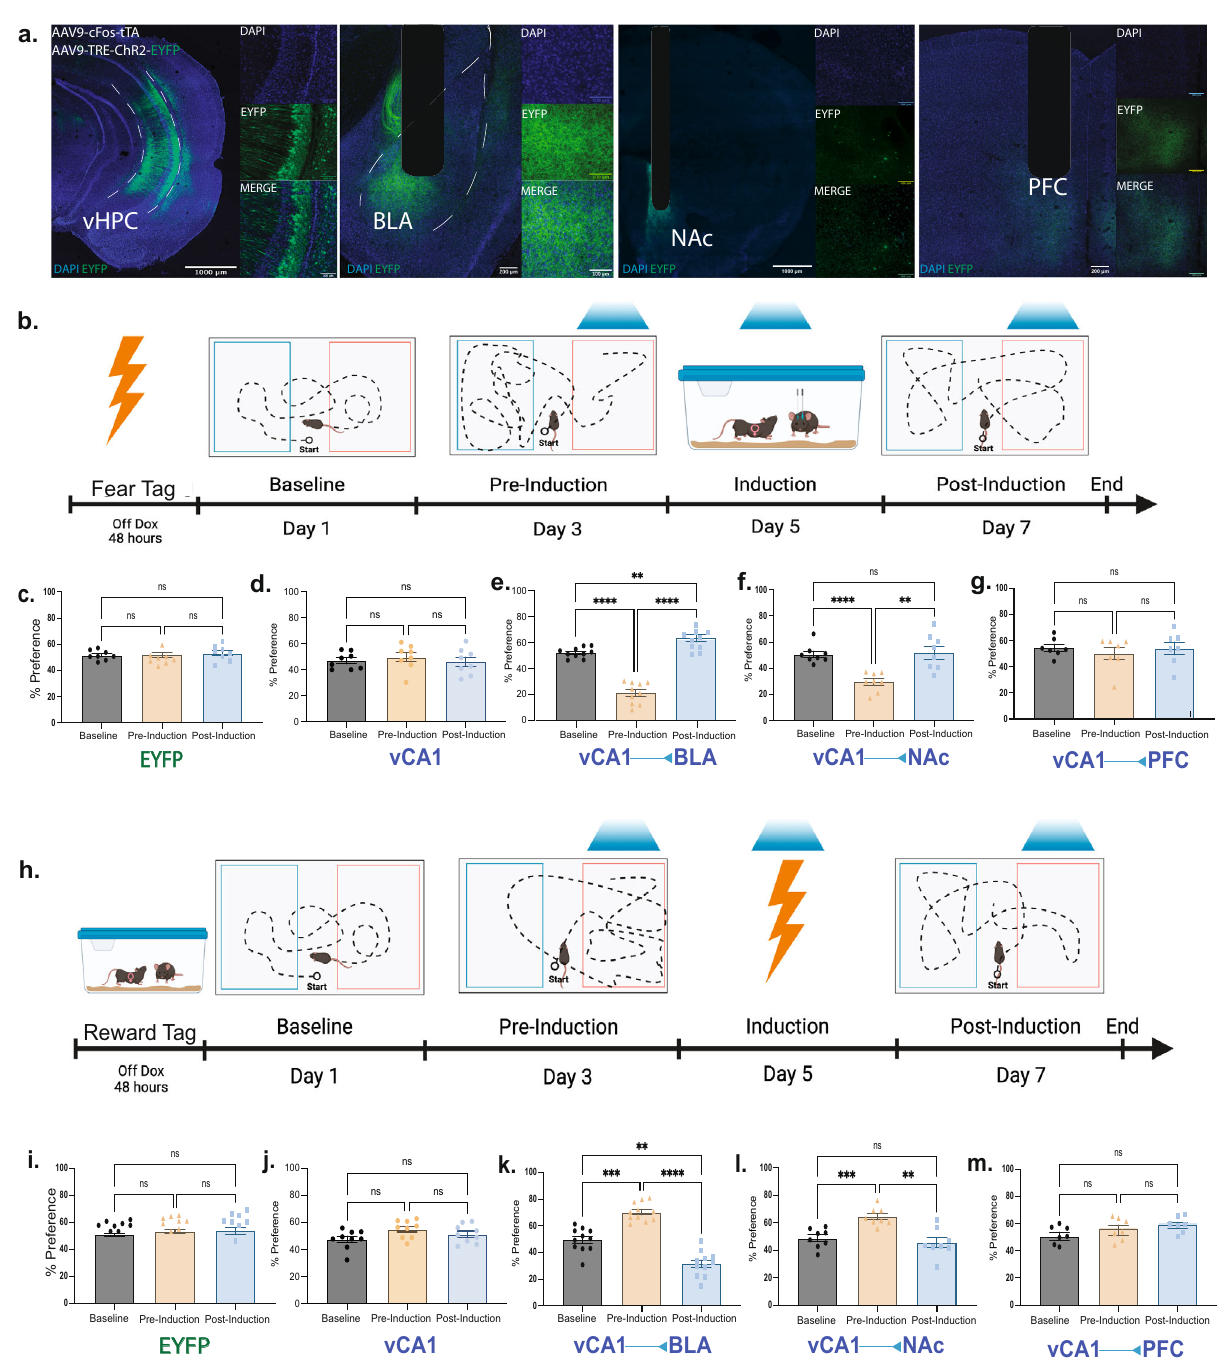
Fig. 6 Hippocampal valence speci fi c outputs are suf fi cient to drive preference or aversion in a projection-speci fi c and functionally reversible manner. Mice were injected with a virus cocktail of AAV9-c-Fos-tTA AAV9-TRE-ChR2-EYFP or AAV9-TRE-EYFP into vCA1 and optic fi bers were placed bilaterally over the cell bodies of vCA1 or the terminals from vCA1 to the BLA, Nacc, or the PFC, in separate groups. The mice were then tagged with either a aversive or appetitive experience and subjected to real time opto-place avoidance and preference. a Representative images of ChR2-EYFP labeling cell bodies in vCA1 and its respective terminals in the BLA, NAcc, and PFC. b Fear to reward protocol in which the subjects received stimulation of vCA1 cell body or vCA1 projections to the BLA, NAcc, or PFC terminals. c – g Percent preference for the stimulation side at baseline, preinduction, and postinduction ( n = 7 subjects for EYFP controls, n = 8 subjects for vCA1, n = 8 subjects for BLA, n = 7 for NAcc, and n = 7 for PFC, ** P = 0.0018, *** P = 0.0006, repeated measures one-way ANOVA followed by Tukey ’ s multiple comparison test). h Reward to Fear protocol in which the subjects received stimulation of BLA, NAcc, or PFC terminals originating from vCA1. i – m , Percent preference for the stimulation side at baseline, preinduction, and postinduction ( n = 7 for EYFP, n = 9 for vCA1, n = 8 for BLA, n = 7 for NAcc, and n = 7 for PFC, ns = p > 0.05, ** P = 0.0032, **** P < 0.0001, repeated measures one-way ANOVA followed by Tukey ’ s multiple comparison test. Error bars represent mean ±